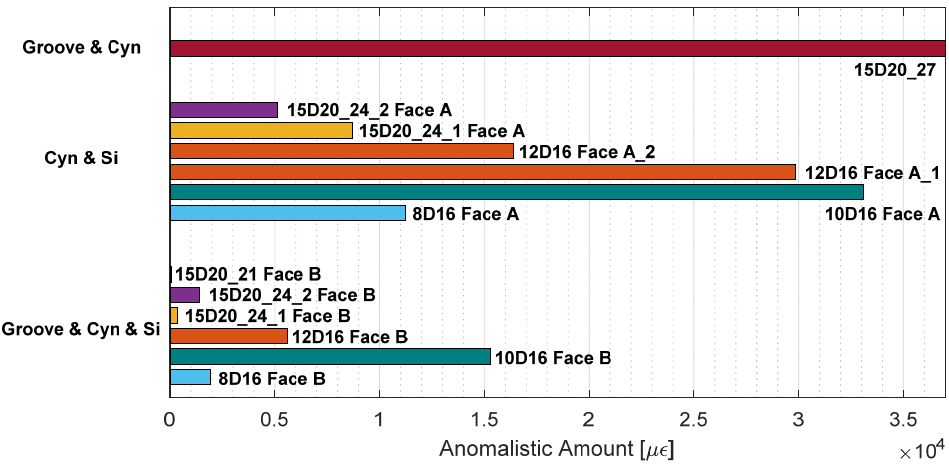
Figure 9. Total amount of anomalistic readings grouped per bonding technique [49].